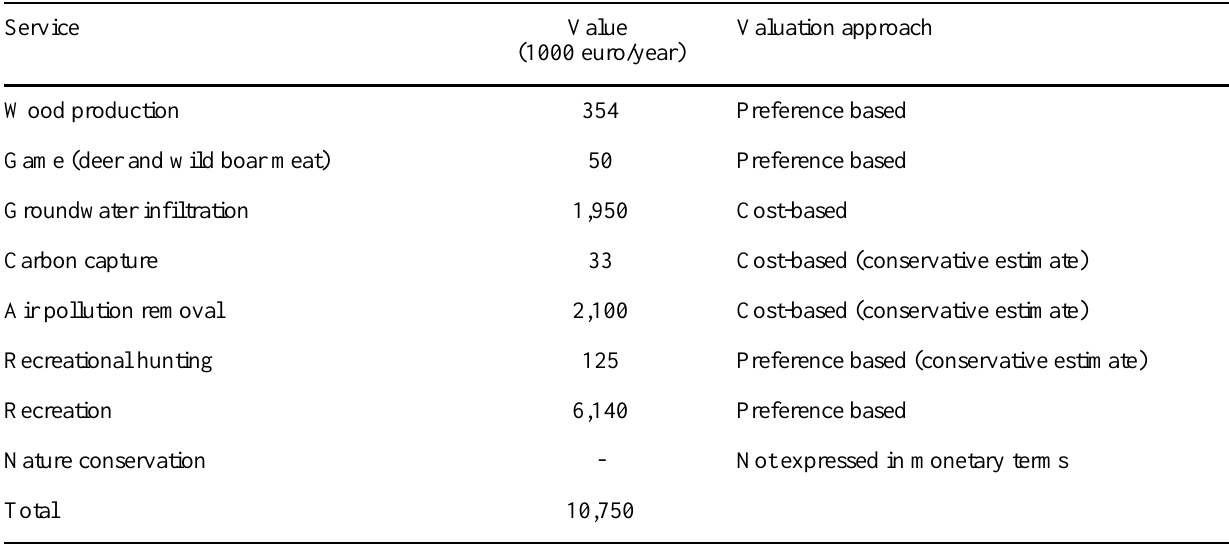
Table 4 . Ecosystem services supplied by the Hoge Veluwe